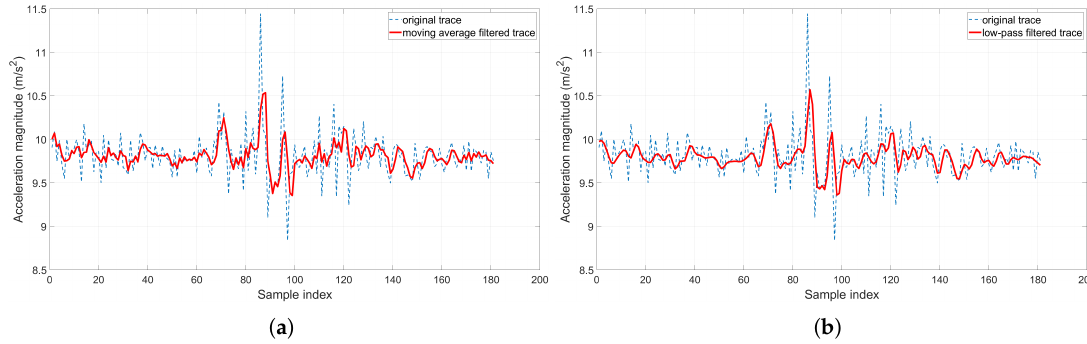
Figure 7. A demonstration of the moving average filter and low-pass filter in action: They significantly reduce the sensor noises and deliver smoother traces. ( a ) Moving average filter; ( b ) Low-pass